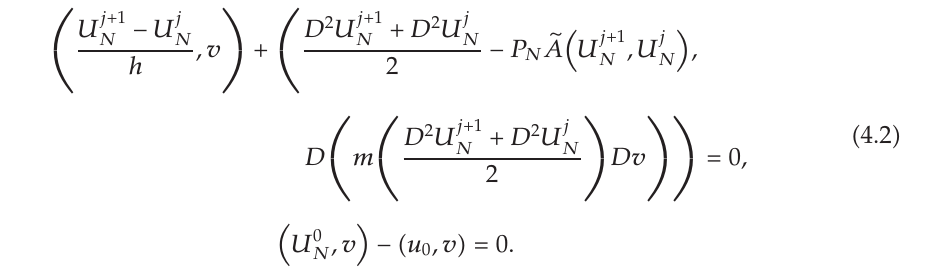
where m 0 > 0 is a constant. The full-discretization spectral method of (cid:7) 2.2 (cid:8) and (cid:7) 2.3 (cid:8)